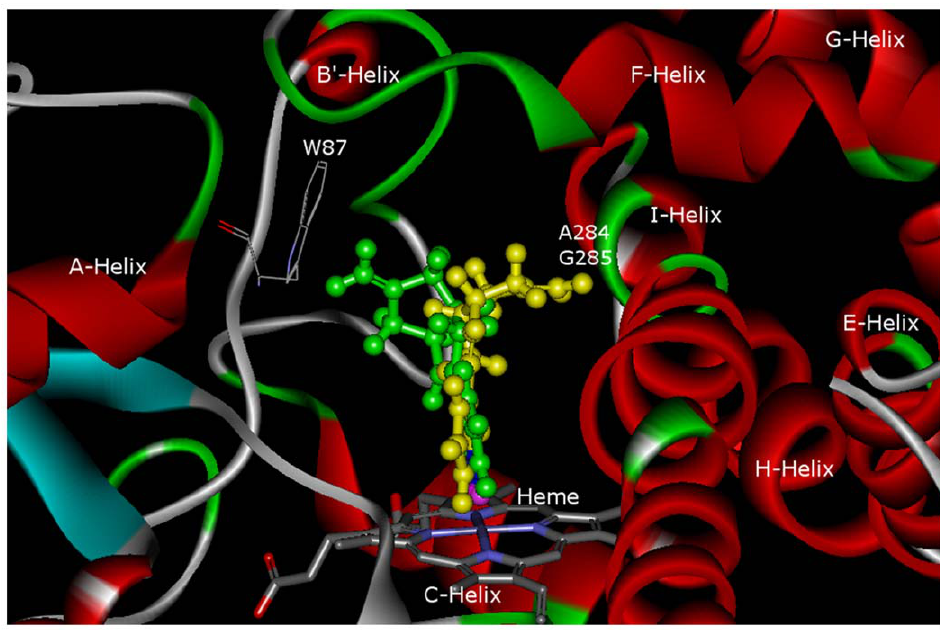
Figure 9. Binding of compound 4 into CYP11B2 homology model.